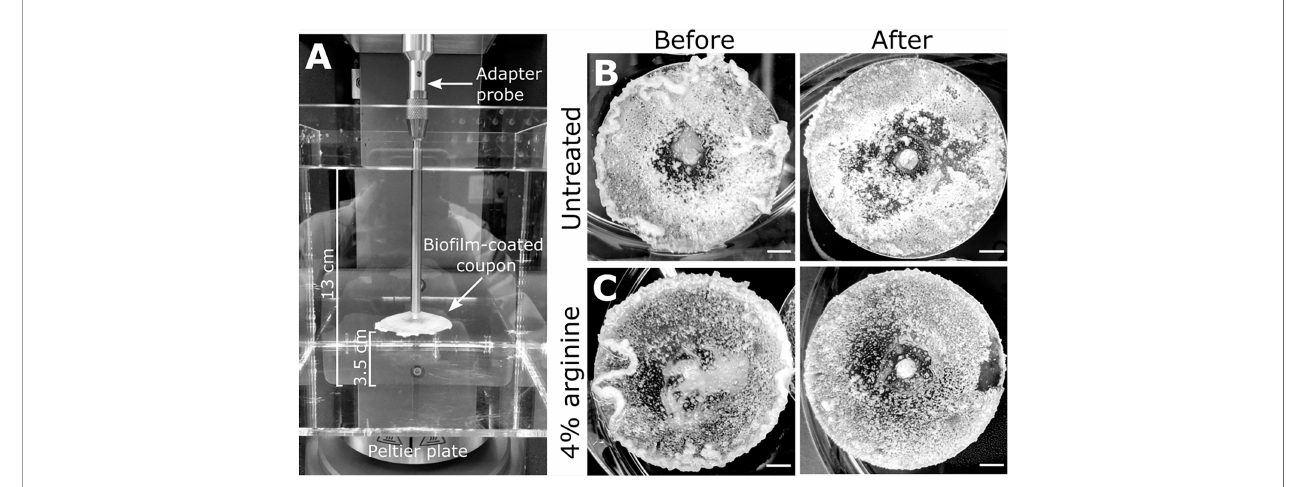
FIGURE 1 | S. gordonii bio fi lms before and after analysis. (A) Experimental design for the adapted rotating-disc rheometry analysis. Bio fi lm-coated coupons were attached to an adaptor probe on the rheometer using a threaded tap that was printed onto the back of the coupon. This was immersed in a container fi lled with reverse osmosis water. A gap thickness of 3.5 cm was set between the coupon and the bottom of the container. Prior to analysis 7 day S. gordonii bio fi lms, grown on the coupons, were treated with either (B) PBS (untreated control) or with (C) 4% arginine (labeled). Images depict bio fi lms before and after rheometry analysis (labeled). Scale bar indicates